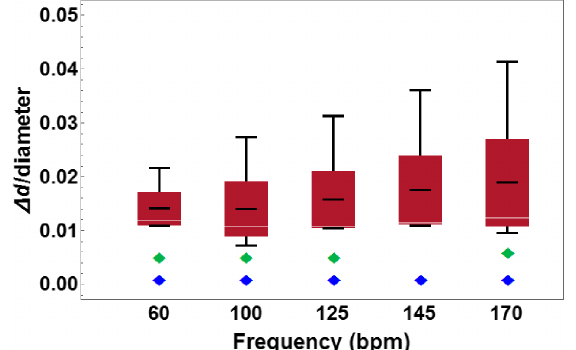
FIG. 8. Comparison of the maximum relative diameter change for human aortas within the 60 – 85 years age group and woven Dacron aortic grafts at different pulse rates. red box, statistical analysis of the data for human aortas for the 60 – 85 years group; green diamond, Dacron graft tested in [5] with an axial pre-stretch of 1.3; blue diamond, Dacron graft tested by the present authors with an axial pre-stretch of